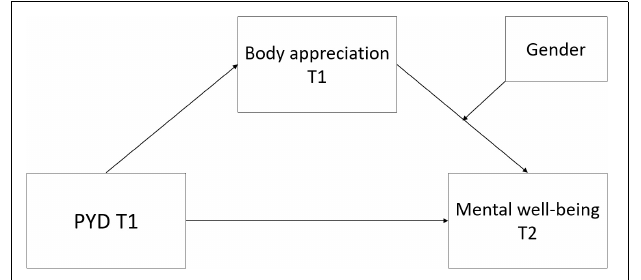
FIGURE 1 | The conceptual second stage moderated mediation